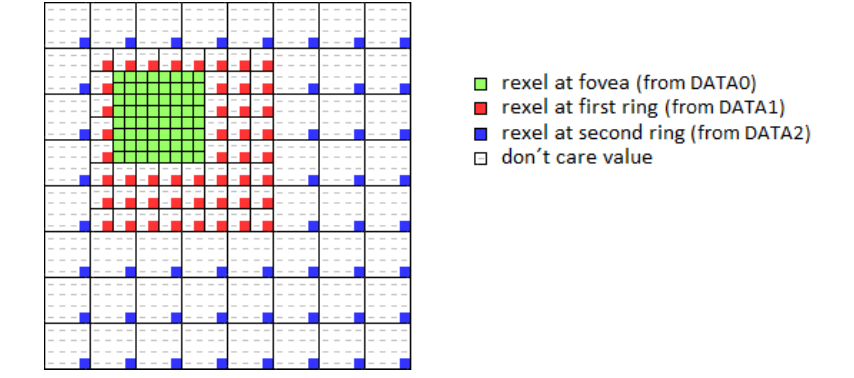
Figure 7. Foveal Image embedded in a full image. CFG defined by L d = 1, R d = 3, T d = 1, B d = 3. Only the fovea, the first and second rings are